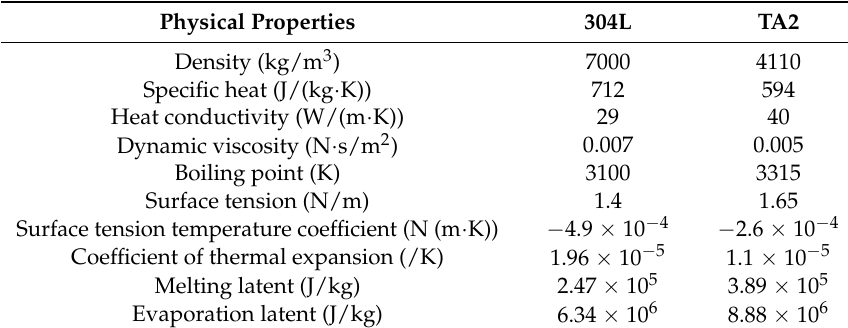
Table 3. Physical properties of 304L and TA2